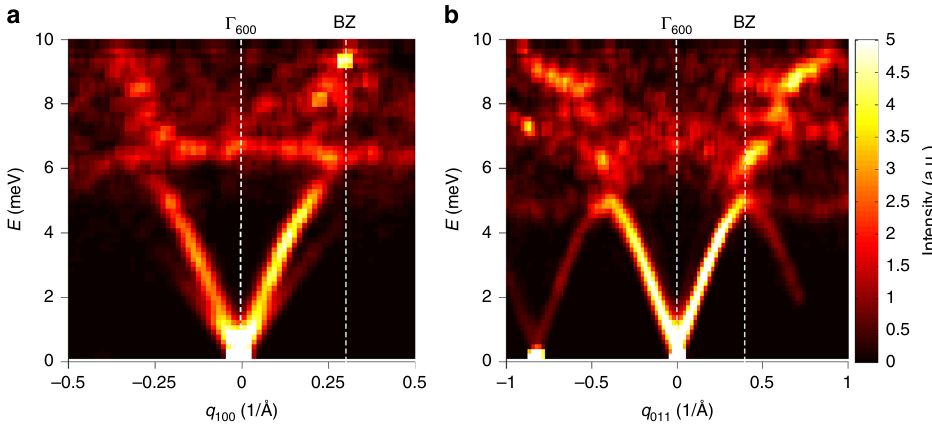
Fig. 2 Experimental surface mapping of the longitudinal acoustic (LA) and transverse acoustic (TA) phonon dispersions in Ba 7.81 Ge 40.67 Au 5.33 measured at 300 K. Two-dimensional inelastic neutron scattering intensity distribution as measured on the neutron time-of- fl ight spectrometer (IN5@ILL) at room temperature around the strong zone center Γ 600 ( Q = 3.6 Å − 1 ). a LA phonons measured along the [100] direction. Well-de fi ned propagating excitations are only observed for LA modes with an energy lower than 6 meV. b TA phonons propagating along [011] and polarized along [100]. Well-de fi ned propagating excitation are only observed for TA modes with an energy lower than